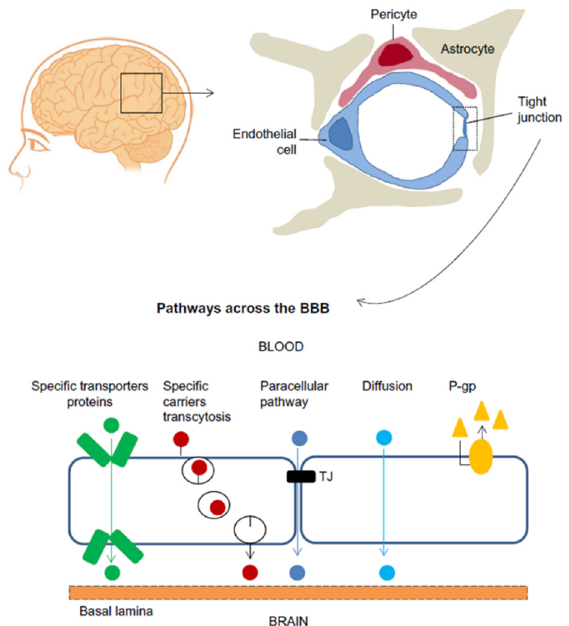
Figure 1. Cellular constituents of the blood-brain barrier (BBB). The BBB is formed by brain microvascular endothelial cells (BMECs), which are connected by tight junctions. The endothelium, together with the basal lamina, pericytes, and astrocytic end-feet forms the neurovascular unit. Some substances diffuse freely into and out of the brain parenchyma, others such as nutrients need specific transporters, while molecules such as insulin, leptin and transferrin are transported by receptor- mediated transcytosis. (Reprinted from Reference [11] in accordance with the Creative Commons Attribution).